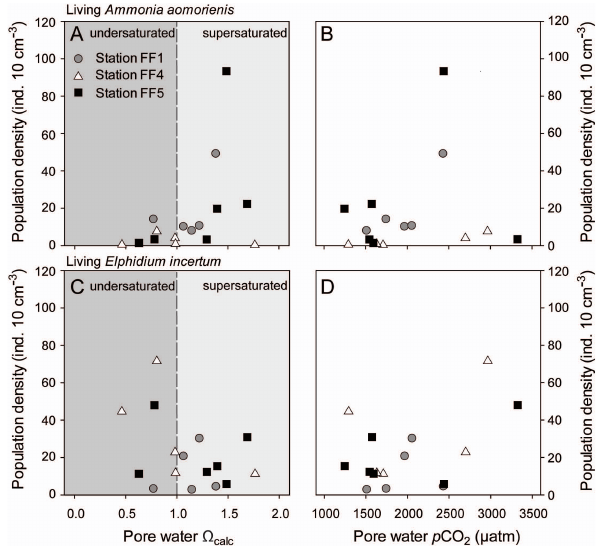
Fig. 5. Population density of living A. aomoriensis ( A and B ) and E. incertum ( C and D ) vs. sediment pore water (cid:127) calc ( A and C ) and p CO 2 ( B and D ). The different symbols present stations FF1, FF4 and FF5 during the one year